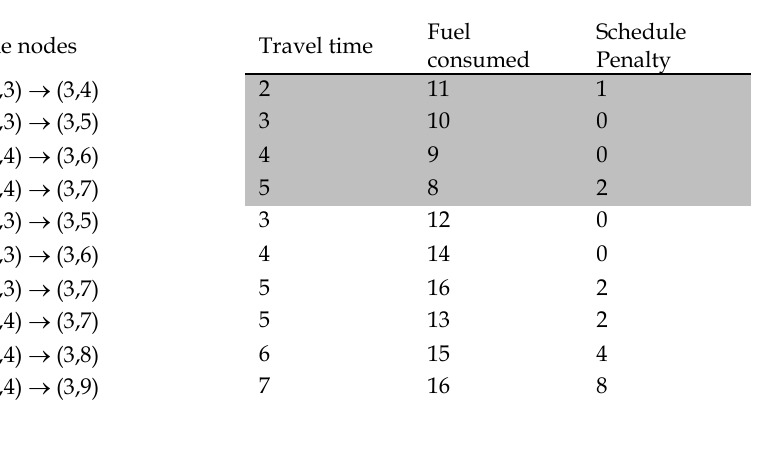
Enumerated space-time-feasible trajectories for four-node example (no stops), with Pareto optimal solutions